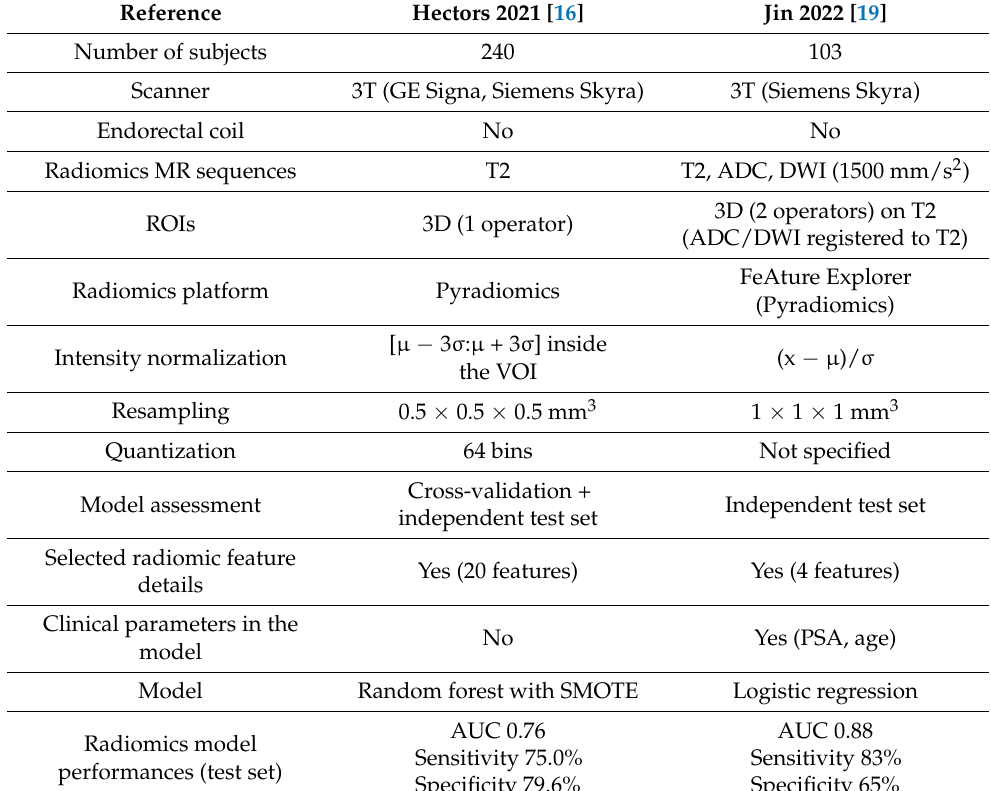
Table 3. Selected models’